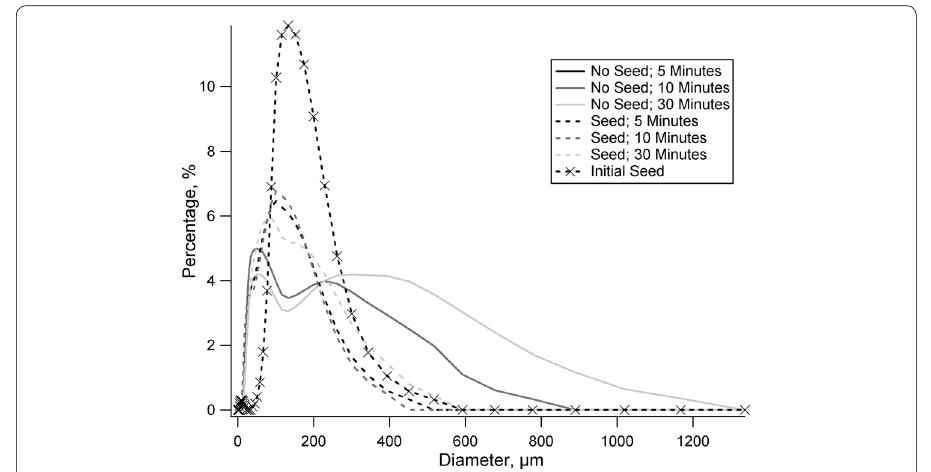
Fig. 7 Particle size analyzer results of silica mitigation process at 800 rpm, pH 8 and 25 ° C